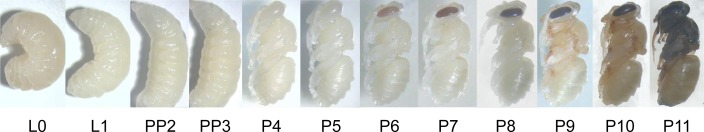
Morphology and color changes during the 12 days of capped brood.Larval (L) stage has 2 days (because we included the 0 h capped brood as the same day of being capped, L0), prepupae (PP) has 2 days and the rest are pupae (P4-P11). On day 12 the worker would eclose (emerge) as an adult.